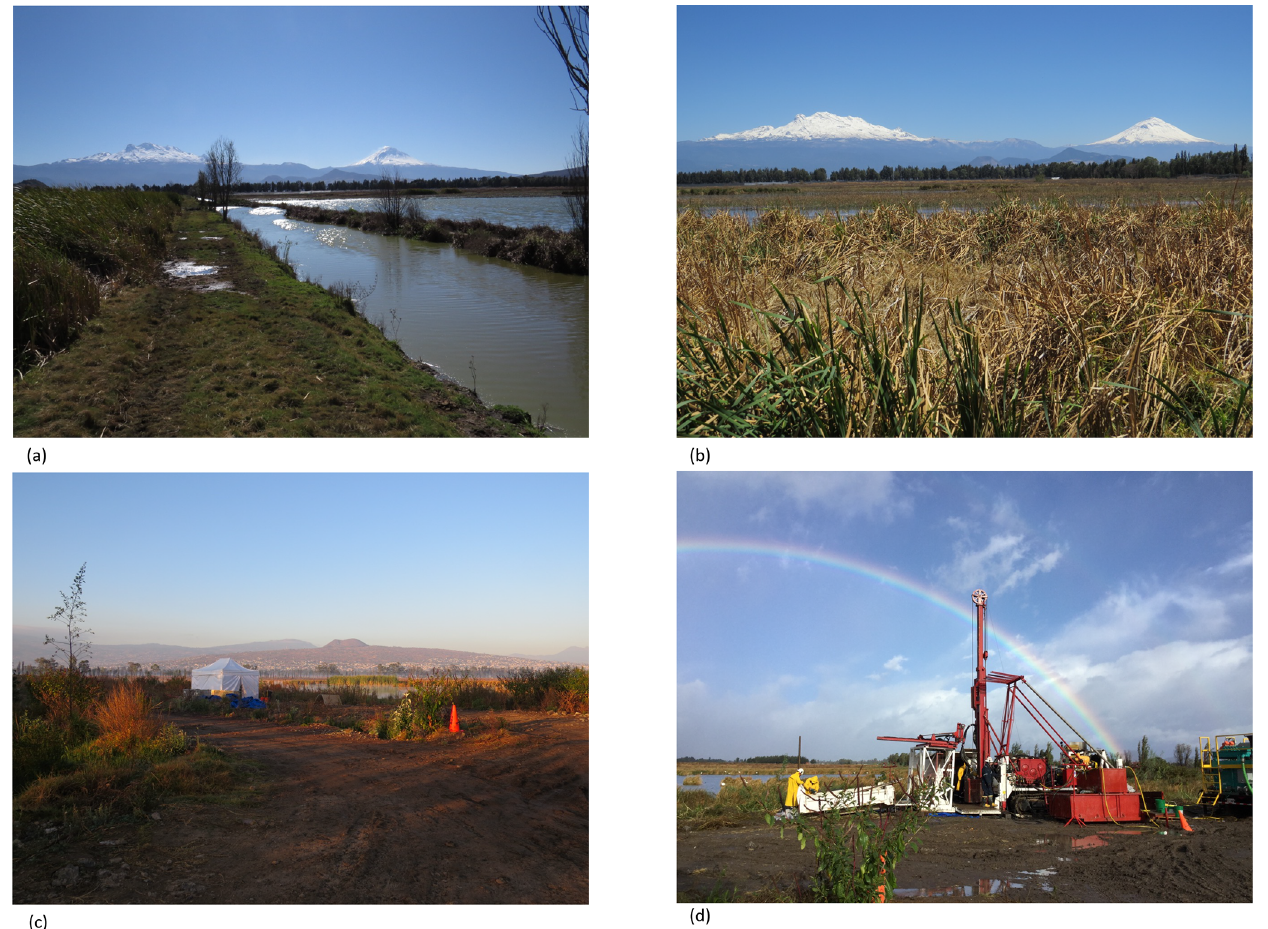
Figure 4. Field images mosaic. Panels (a) and (b) are southeastward views from the field area showing the prominent stratovolcanoes Iztaccihuatl and Popcatépetl, which are, respectively, to the left and the right in these images. Panel (c) is a west-southwest view from the drill site looking toward Teuhtli volcano, one of the cones within the Sierra Chichinautzin volcanic field. Panel (d) is a northeasterly view of the Chalco Basin with the drill